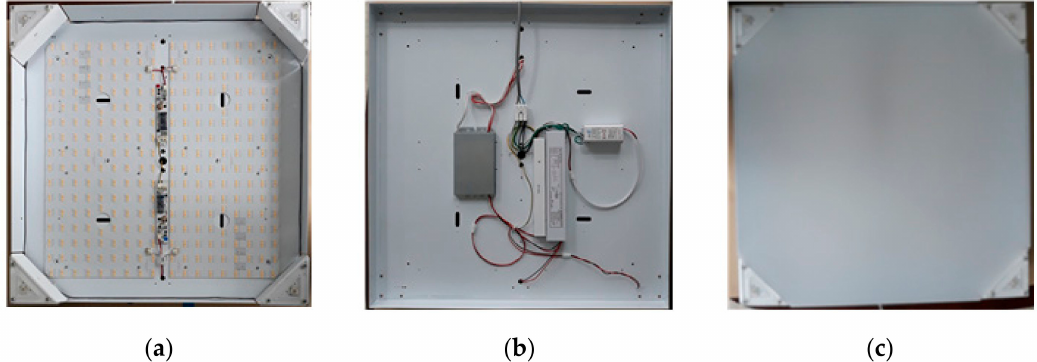
Figure 2. UVB-LED General Lighting. ( a ) Anterior-interior. ( b ) Posterior-converter and drive control system. ( c ) Anterior-di ff user